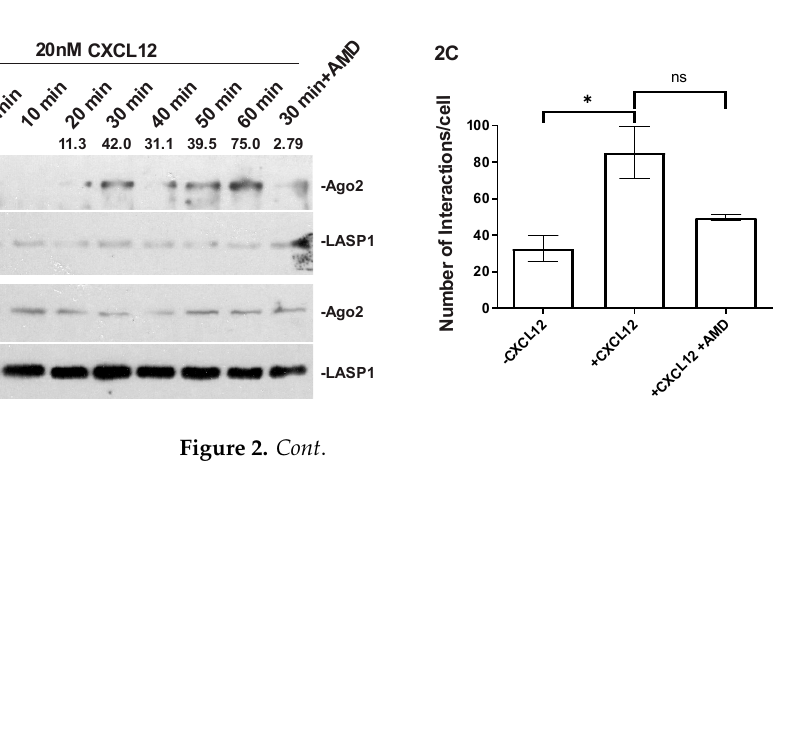
Figure 2. CXCR4-Dependent Association of LASP1 with Ago2 in situ. ( A ) Co-immunoprecipitation of Ago2 with LASP1 after stimulation of 231S cells with 20 nM CXCL12 for 0–60 min, with added unstimulated mock control and 30 min stimulation with added 100 nM AMD3465. Total protein lysates were resolved by 10% SDS-PAGE and immunoblotted for LASP1 and Ago2 ( n = 3). ( B ) Proximity ligation assay of the LASP1-Ago2 interaction in Bone-Un cells under four conditions: 20 nM CXCL12 stimulation for 30 min(+ CXCL12); 20 nM CXCL12 stimulation for 30 min with pre- treatment of cells with 100 nM AMD3465 for 30 min (+ CXCL12 and AMD3465); unstimulated Bone- Un cells ( − CXCL12); and single antibody control with no Ago2 antibody. The interactions were visualized as immunofluorescent dots (pseudo-colored red), the cellular outlines were marker by F- actin staining with Phalloidin (pseudo-colored green), and nuclei by DRAQ5 (pseudo-colored blue). Merged images of all three channels are provided ( n = 2). ( C ) Quantification of PLA interaction spots by ImageJ (Version 1.8.0, https://imagej.nih.gov/) particle analysis. At least 50 cells from each